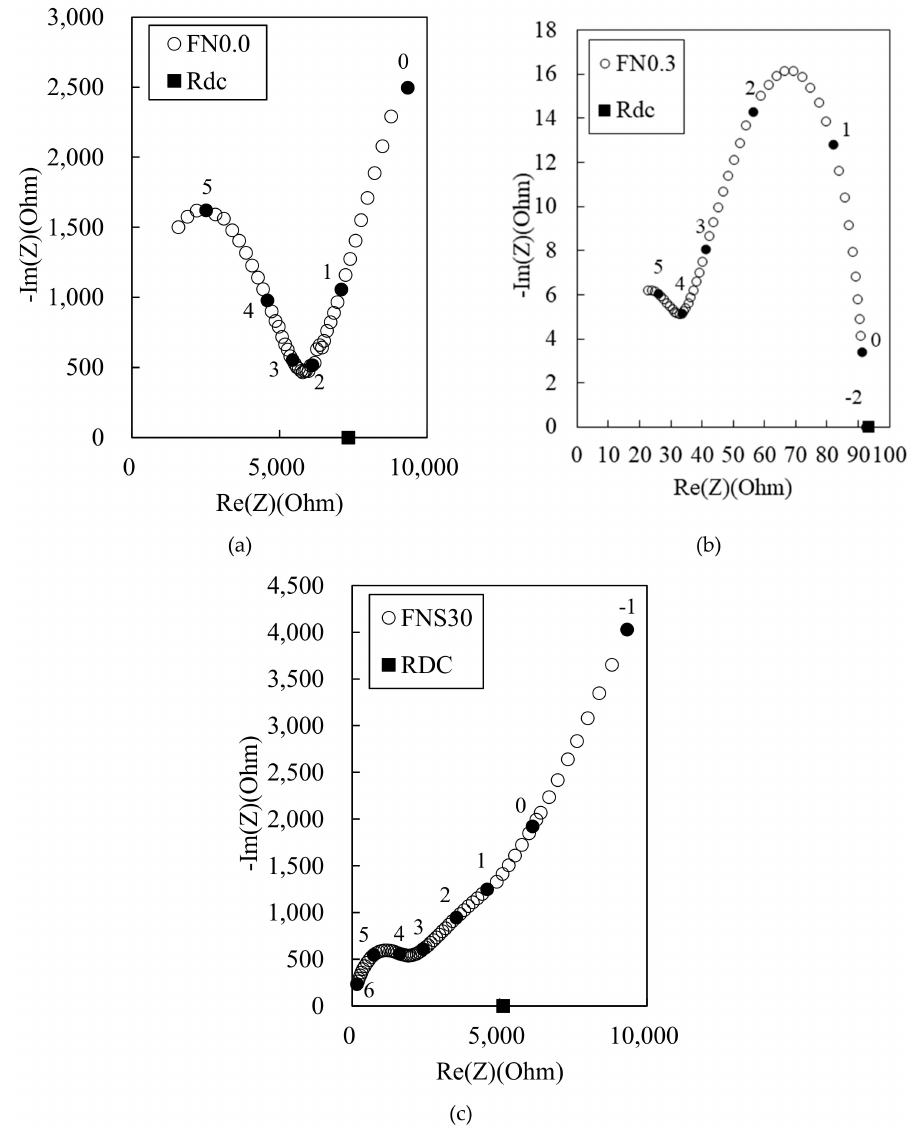
Figure 6. Experimental Nyquist plot for 100 MPa-HPFRCC with ( a ) 0% and ( b ) 0.3% MWCNT, and with ( c ) MWCNT solution at 30% replacement of mix